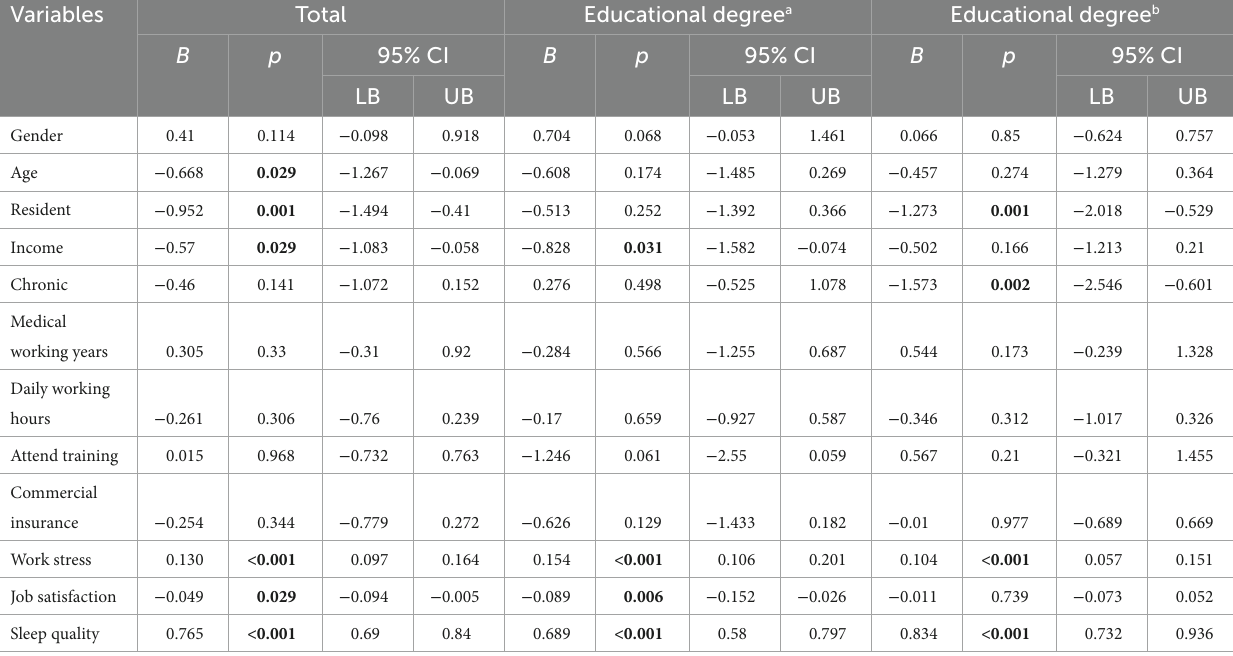
TABLE 2 Multiple regression analysis of variables related to depression.